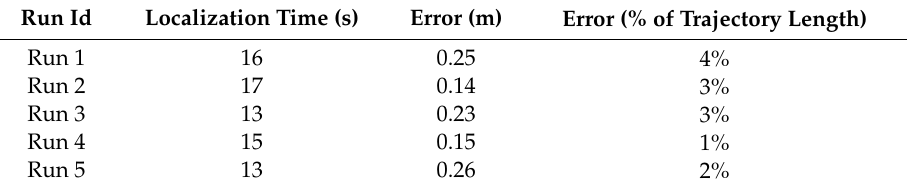
Table 2. Localization accuracy.